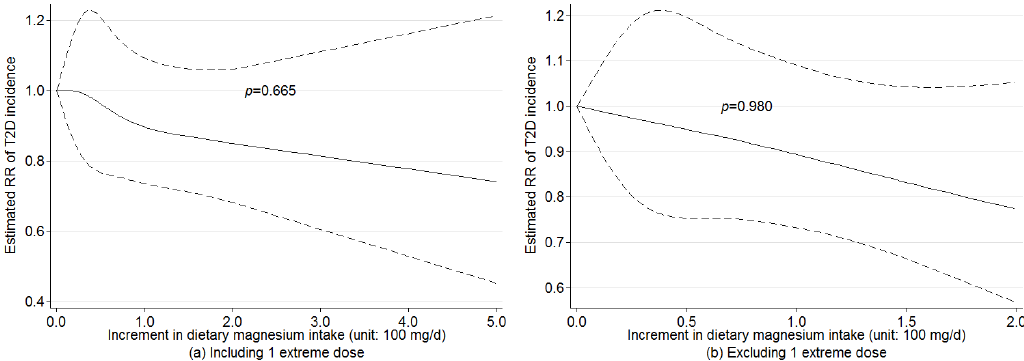
Figure 5. Examination of nonlinear association between increment in dietary magnesium intake and risk of T2D incidence by random ‐ effects model with the use of restricted cubic splines.